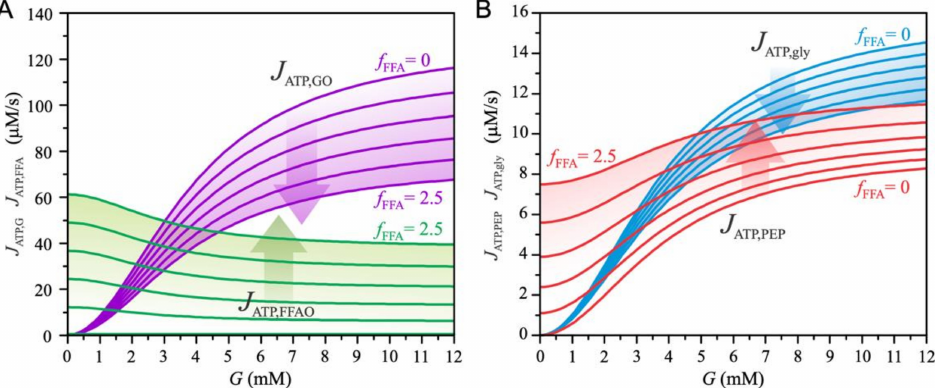
Figure 2. Glucose-dependent metabolic fluxes of ATP production and the effects of beta cell exposure to FFA ( f FFA ). The parameter f FFA is varied between 0 and 2.5 with a step size of 0.5. ( A ) ATP production due to glucose oxidation ( J ATP,GO ) and ATP production due to FFA oxidation ( J ATP,FFAO ). ( B ) ATP production due to the PEP cycle ( J ATP,PEP ) and due to glycolysis ( J ATP,gly